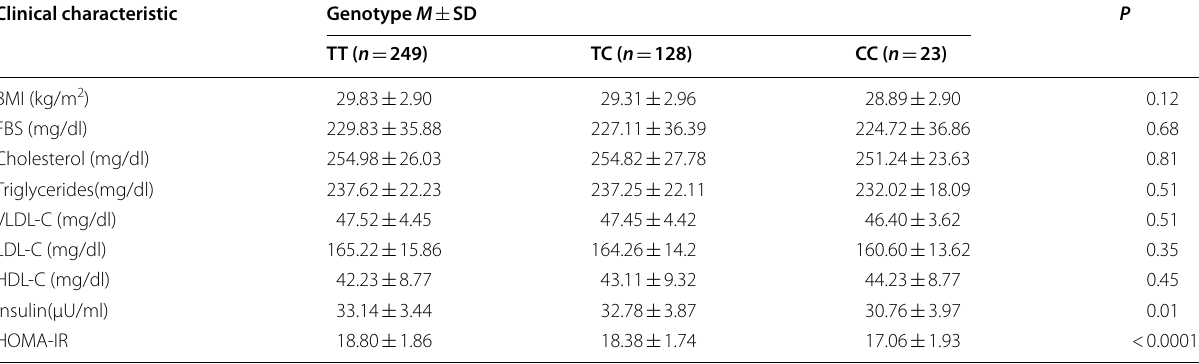
Table 4 Mean comparison of biochemical markers under the Co‑dominant model of CDKN2A/B (rs10811661 T>C) gene